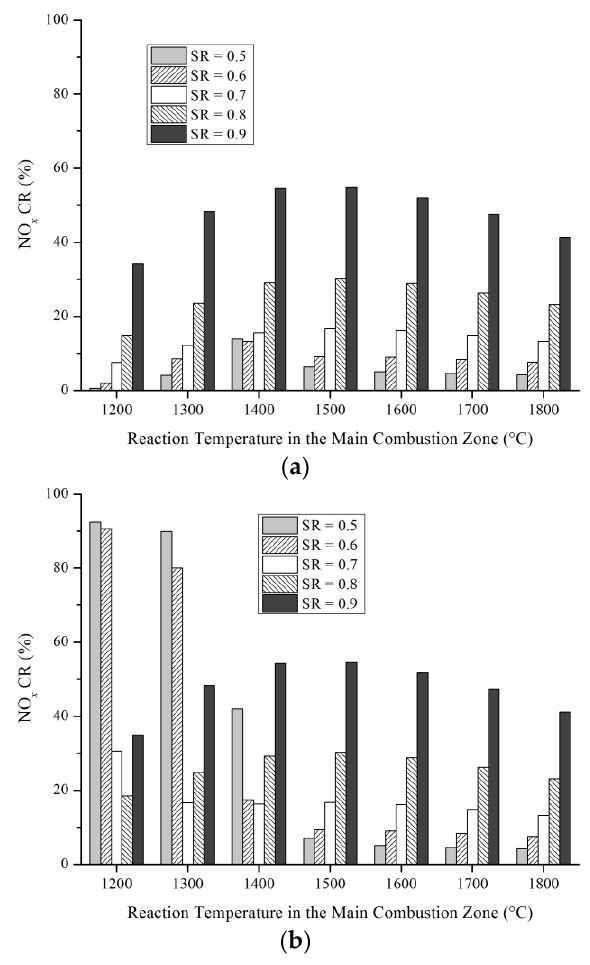
Figure 8. Conversion ratio of fuel-N to NO x in staged O 2 / CO 2 combustion (reaction temperature in the burnout zone: 1100 °C): ( a ) main combustion zone exit; ( b ) burnout zone exit.